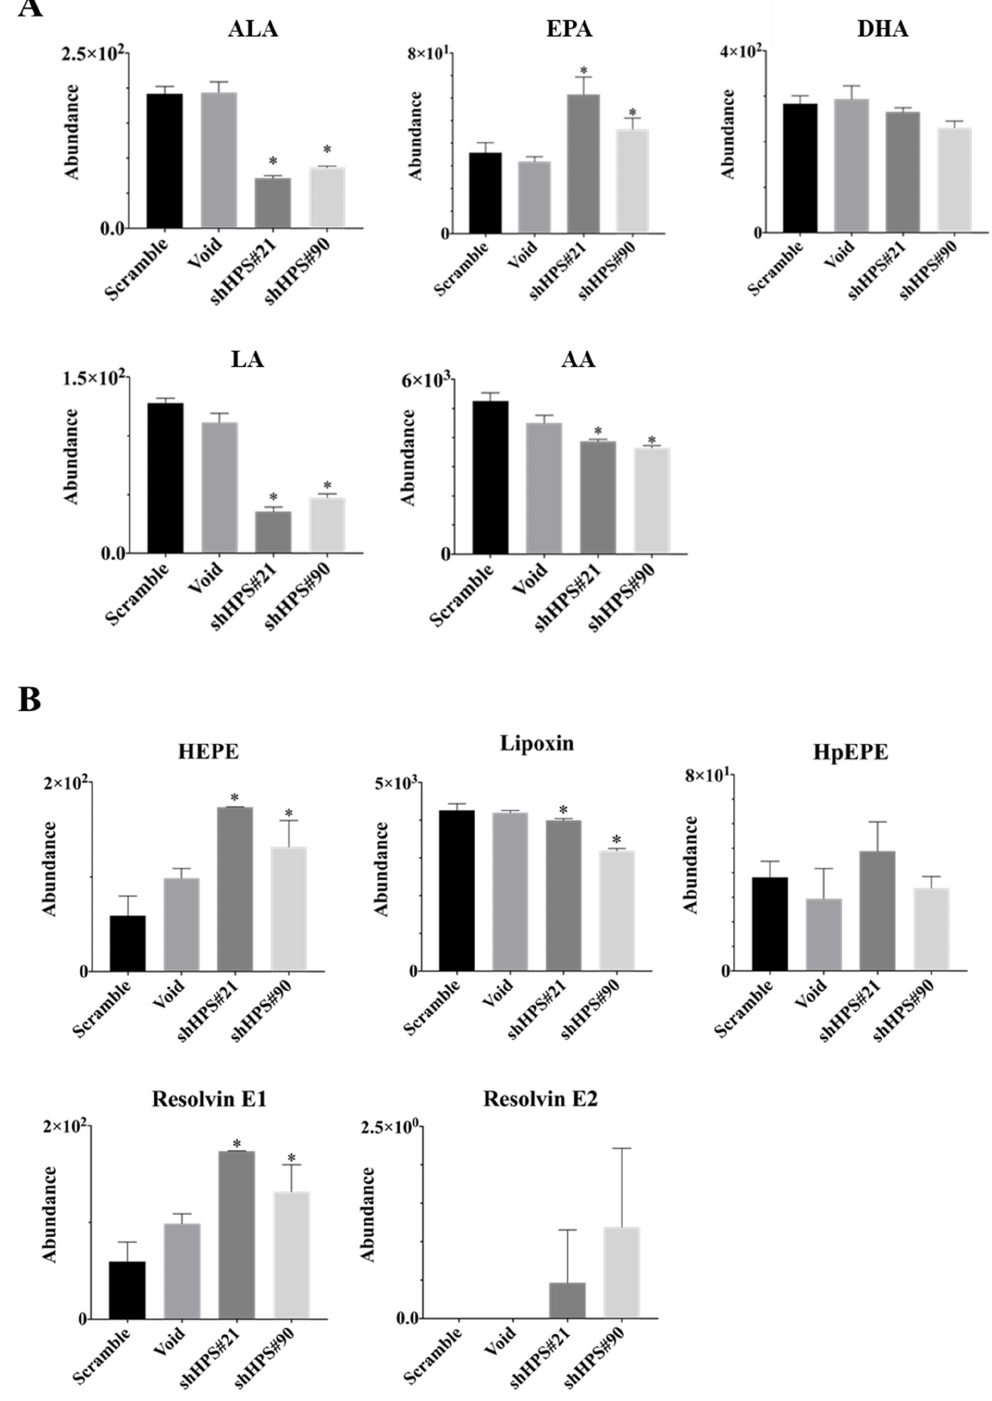
Figure 4. Knockdown of hepassocin (HPS) in SUIT-2 cells changes the lipid profile. ( A ) Expression levels of α -linolenic acid (ALA), eicosapentaenoic acid (EPA), docosahexaenoic acid (DHA), linoleic acid (LA), and arachidonic acid